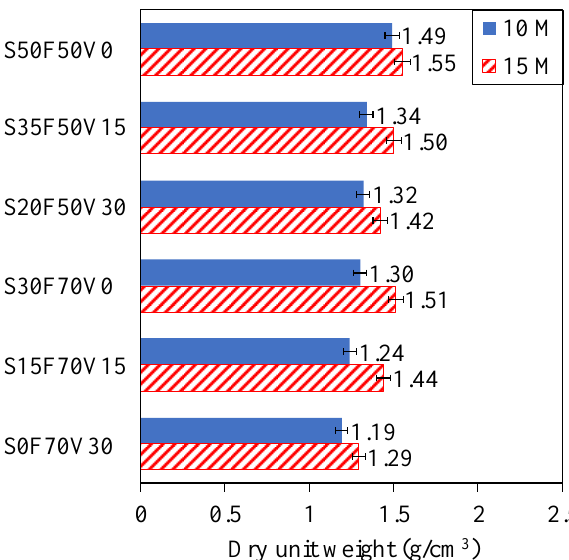
Figure 7. Dry unit weights of the geopolymer mortar.